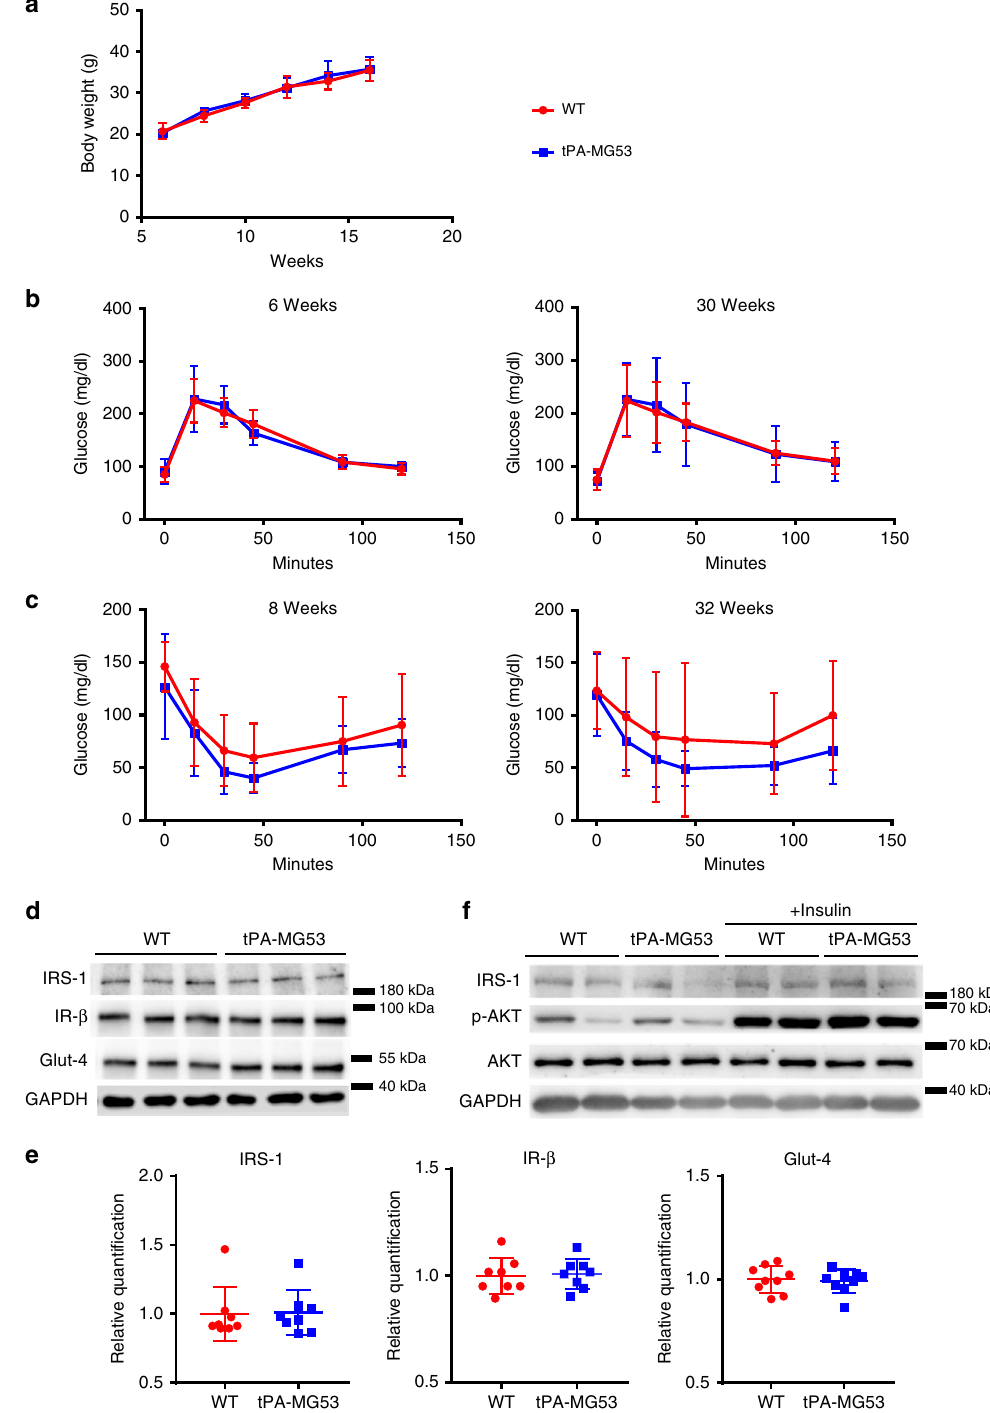
Fig. 2 Assessment of insulin signaling and glucose handling in tPA-MG53 and WT mice. a tPA-MG53 and WT littermate mice at 6 weeks were treated with HFD and the changes in body weight were followed for 10 weeks ( n = 5 per group). b Glucose tolerance tests were conducted with tPA-MG53 and WT littermates at the age of 6 weeks (left) and 30 weeks (right). c Insulin-tolerance tests were conducted with tPA-MG53 and WT littermates at the age of 8 weeks (left) and 32 weeks (right). n = 6 for WT, n = 5 for tPA-MG53. d TA muscle (60 µ g total protein per lane) derived tPA-MG53 and WT littermates were probed with antibodies against IRS-1, IR- β , Glut-4. GAPDH serves as loading control. e Quanti fi cation of protein expressions based on western blot. f tPA-MG53 and WT mice were treated with insulin (0.75 U/kg) for 15 min, fresh TA muscles were probed with antibodies against IRS-1, p-Akt, Akt, and GAPDH. Error bar represents the standard